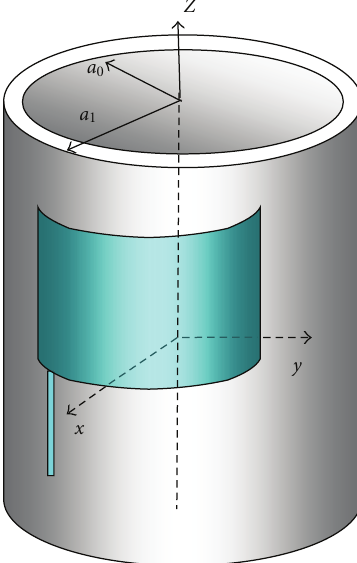
Figure 8: CCMA fed by microstripline.